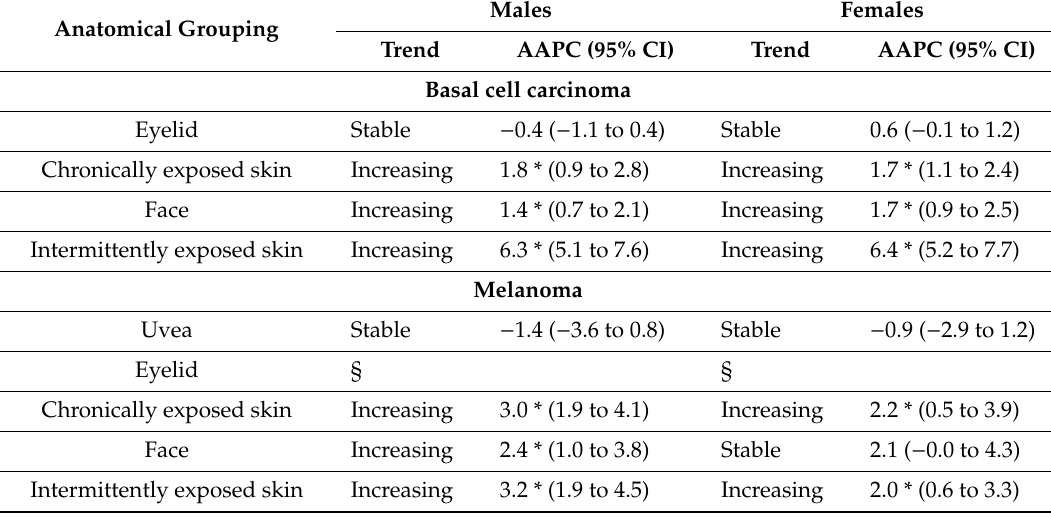
Table 2. Incidence trends and the average annual percent change (AAPC) for ophthalmic and non-ophthalmic basal cell carcinoma and melanoma,